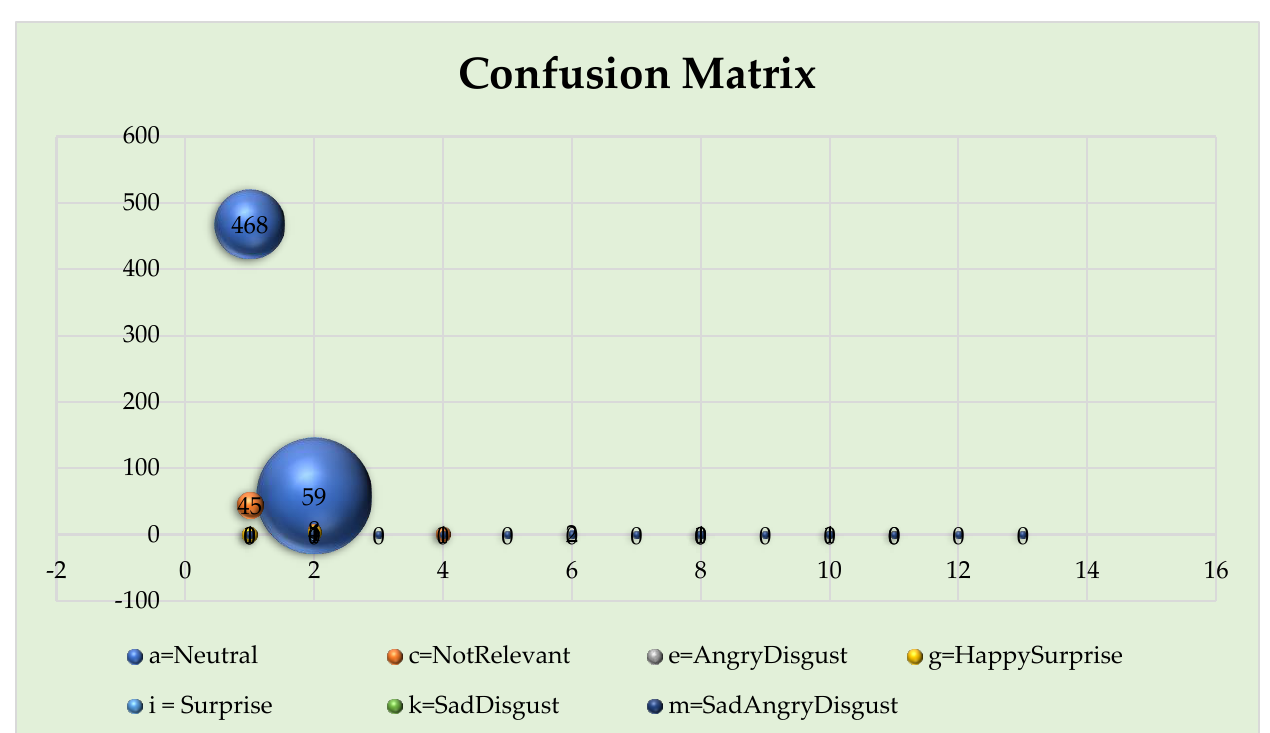
Figure 7. Graphical representation of confusion matrix (single feature selection technique).